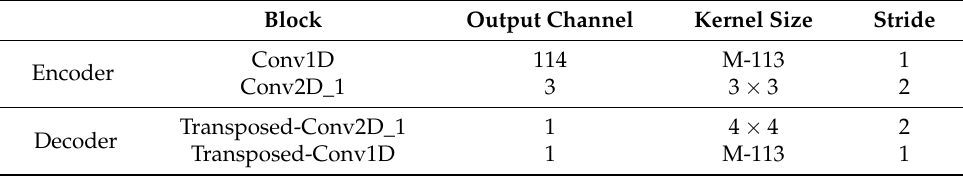
Table 3. Structure 2: Removing two 2D-convolutional layers of the